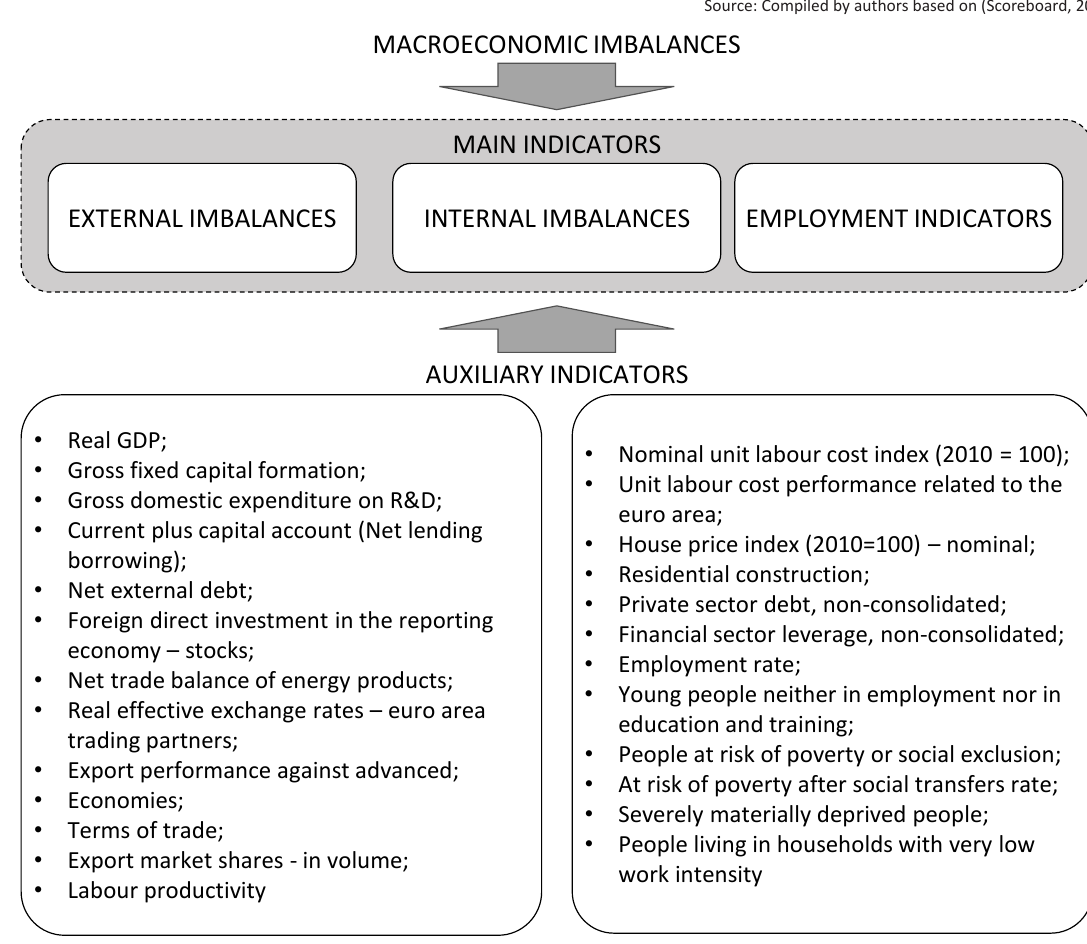
Figure 2. The scheme of measuring the macroeconomic